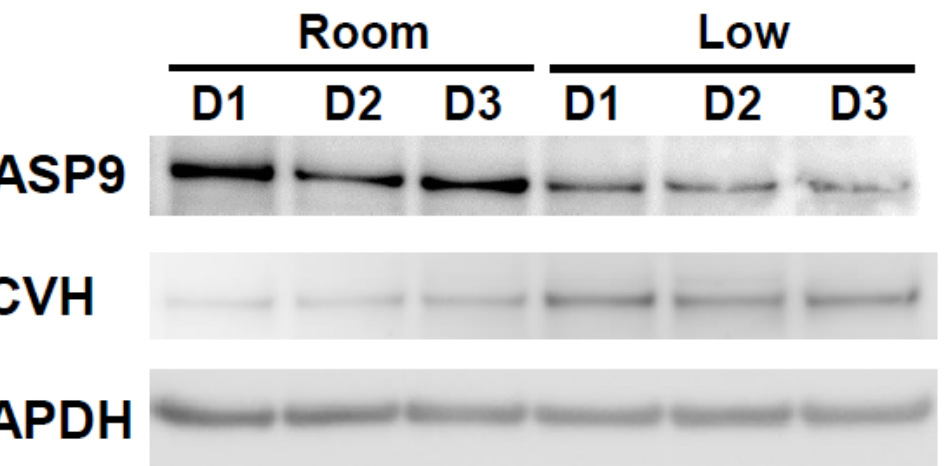
Figure 3. Influence of different storage condition on CASP3 , CASP9 and SOD1 mRNA expressions in hen ovarian tissue. Mean (± SEM) percentages of relative gene expression in different conditions (low temperature, room temperature for 1 to 3 days).